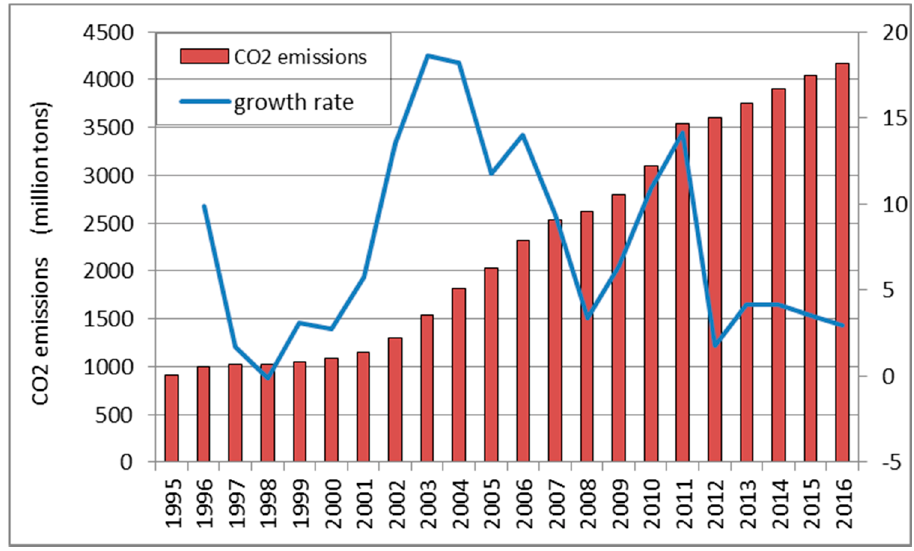
Figure 1. Growth of CO 2 emissions in the power sector.